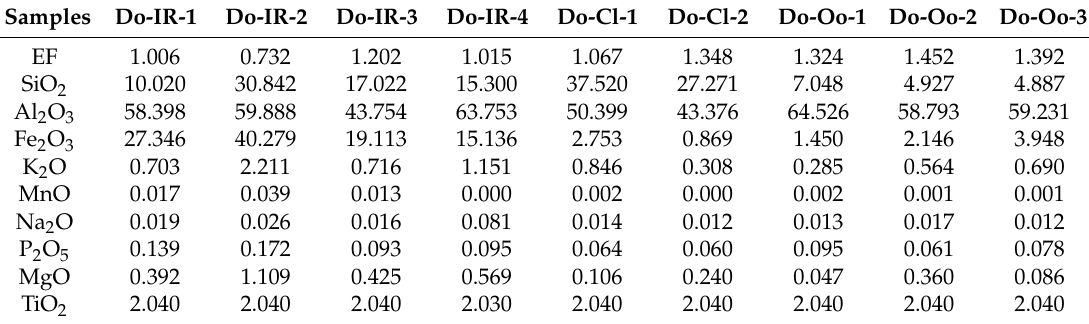
Table 5. Mass changes (in %) of the Dopolan samples based on the reconstructed compositions (RC, in wt %). Samples